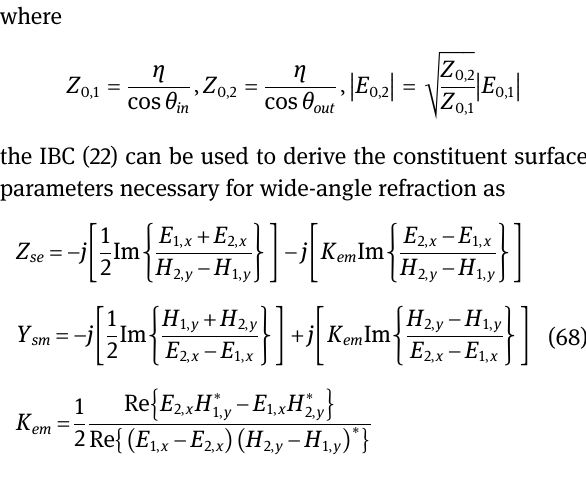
necessary to obtain a reactive and symmetric impedance matrix representing the metasurface. The design process results in the impedance matrix elements shown in Figure 21e. The metasurface is realized as a stack of three sheets (see Section 4.3) with each cell separated by metallic viastocombattransversecouplingnotmodeledinthedesign (see Figure 21f). The result of the 2D simulation is shown in Figure 21d. The conversion ef fi ciency, de fi ned as the differ- enceoftheoutputpowerfromPort3( P )andtheinputpower 3